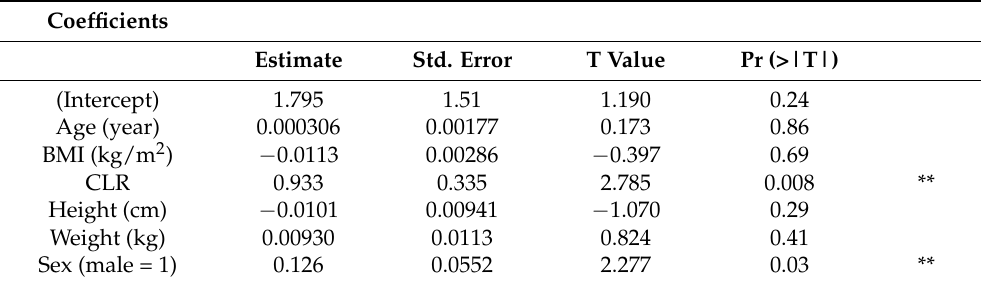
Table 4. Logistic regression of the algorithm obtained from the Hungarian patients on the femoral neck. Coefficients